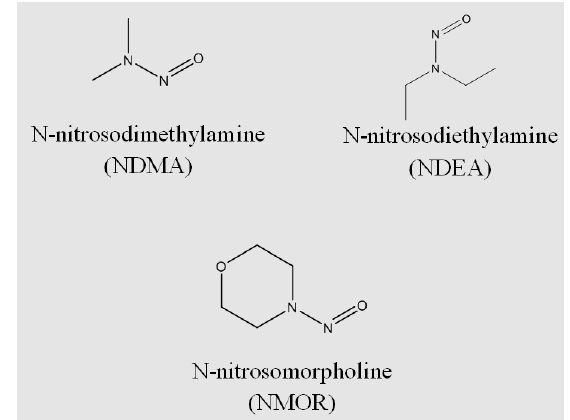
Figure 1. Chemical structures of N-nitrosamines compounds.